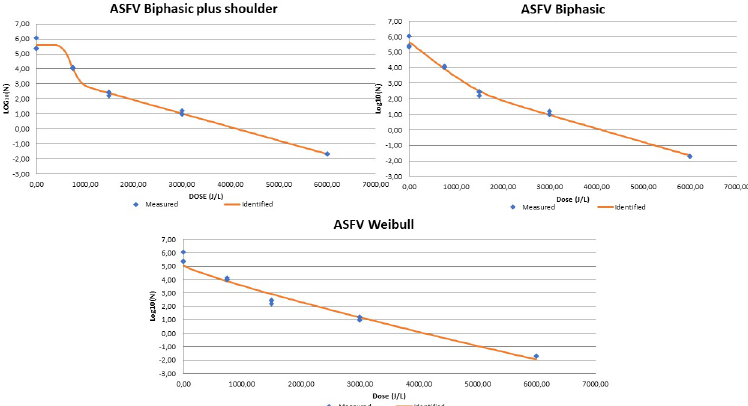
Fig 1. Mean ASFV Log10/mL values after UV-C irradiation of porcine plasma at different UV irradiation doses. Best fit mathematical models are shown. Blue diamonds indicated measured results of the viral titer at different UV-C irradiation doses expressed as mean log 10/mL (n = 3 replicates). Red line is the identified inactivation curve model.